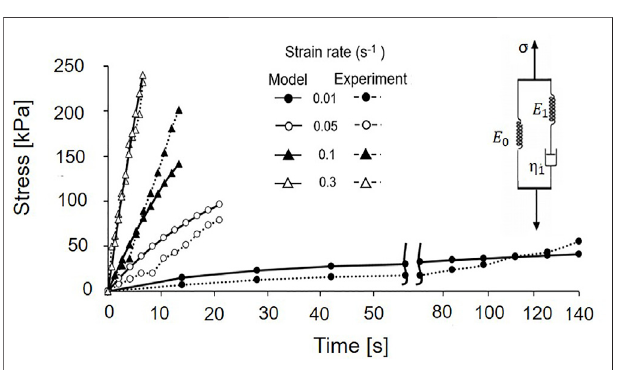
FIGURE 6 | Global fi tting of the SLS model and experimental data sets.